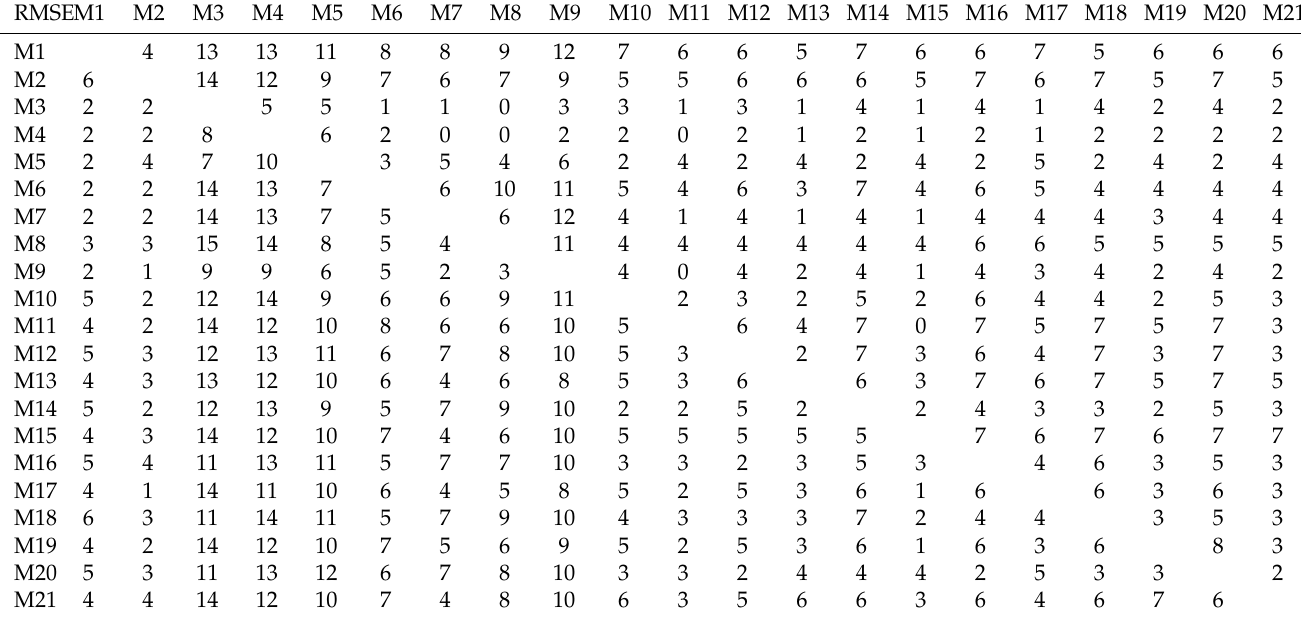
Table 19. RMSE for DM test in out-of-sample tourism demand volatility